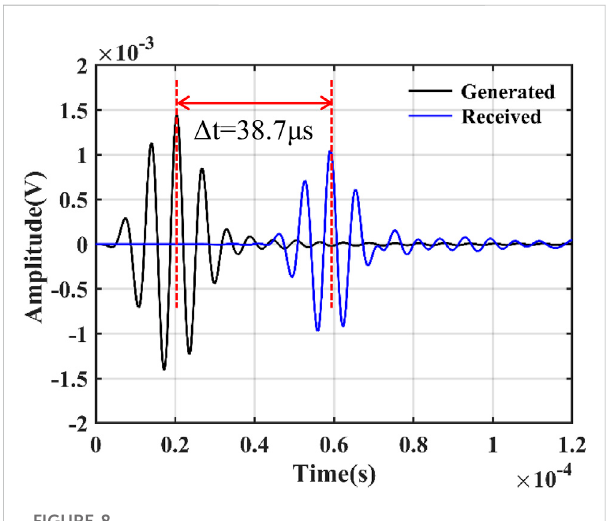
FIGURE 10 Radial depth variation pattern of cement bonding